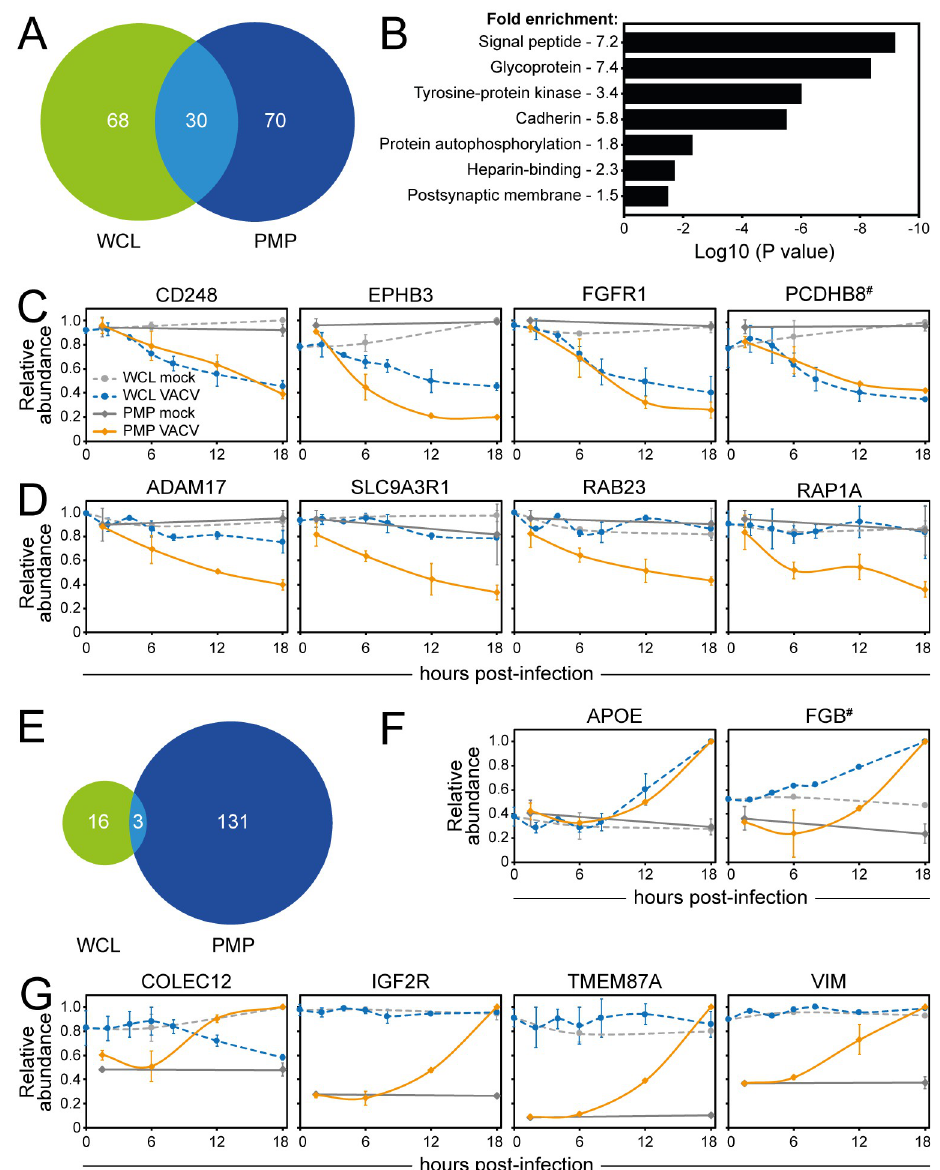
Fig 8. Cell surface-specific regulation of protein expression during VACV infection. ( A ) Overlap of downregulated proteins between PMP and WCL according to ‘sensitive’ criteria (S5A and S5B Table). ‘Sensitive’ criteria WCL (n = 3) [9]: human proteins quantified in any of the replicates and showing on average > 2-fold-change at any time-point (2, 4, 6, 8, 12, 18 hpi) compared to 18 h mock sample. ( B ) DAVID functional enrichment of the 30 proteins commonly downregulated from the cell surface and at whole-cell levels. A background of all proteins detected in PMP and WCL proteomics was used. Representative terms from each cluster with a Benjamini-Hochberg-corrected p-value of < 0.05 are shown (S5C Table). ( C ) Temporal profiles of selected host proteins that were commonly downregulated from the cell surface and at whole-cell level. ( D ) Temporal profiles of selected human PM proteins that were only downregulated at the cell surface, but not at whole-cell level ( E ) Same as panel A using proteins upregulated according to ‘sensitive’ criteria (S5D Table). ( F ) Temporal profiles of selected human PM proteins that were commonly upregulated from the cell surface and at whole-cell level. ( G ) Temporal profiles of selected human PM proteins that are only upregulated at the cell surface, but not at whole-cell level. Data are represented as mean ± SD (PMP n = 2; WCL n = 3 [9], # WCL n <